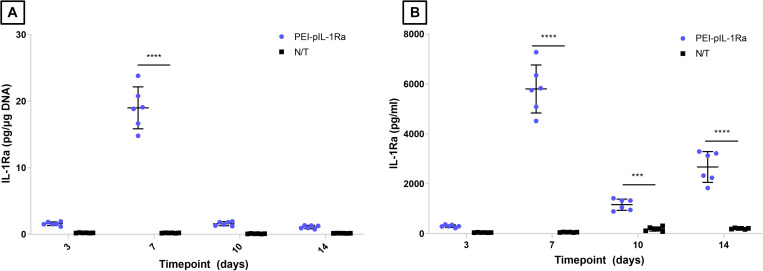
Assessment of IL-1Ra produced by rat BM-MSCs transfected with PEI-pIL-1Ra nanoparticles. Quantification of IL-1Ra produced by BM-MSCs, collected in culture media at 3, 7, 10, and 14 days post-transfection. (A) Data is normalized to μg of dsDNA present in cultures at each timepoint. (B) Data is expressed as pg/ml. *** and **** denotes p < 0.001 and p < 0.0001, respectively. Data plotted represents mean ± standard deviation, n = 3.